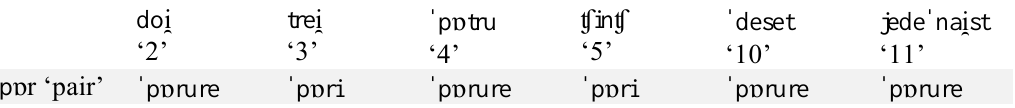
Table 6. Arbitrary selection of the endings -i and -ure in responses from